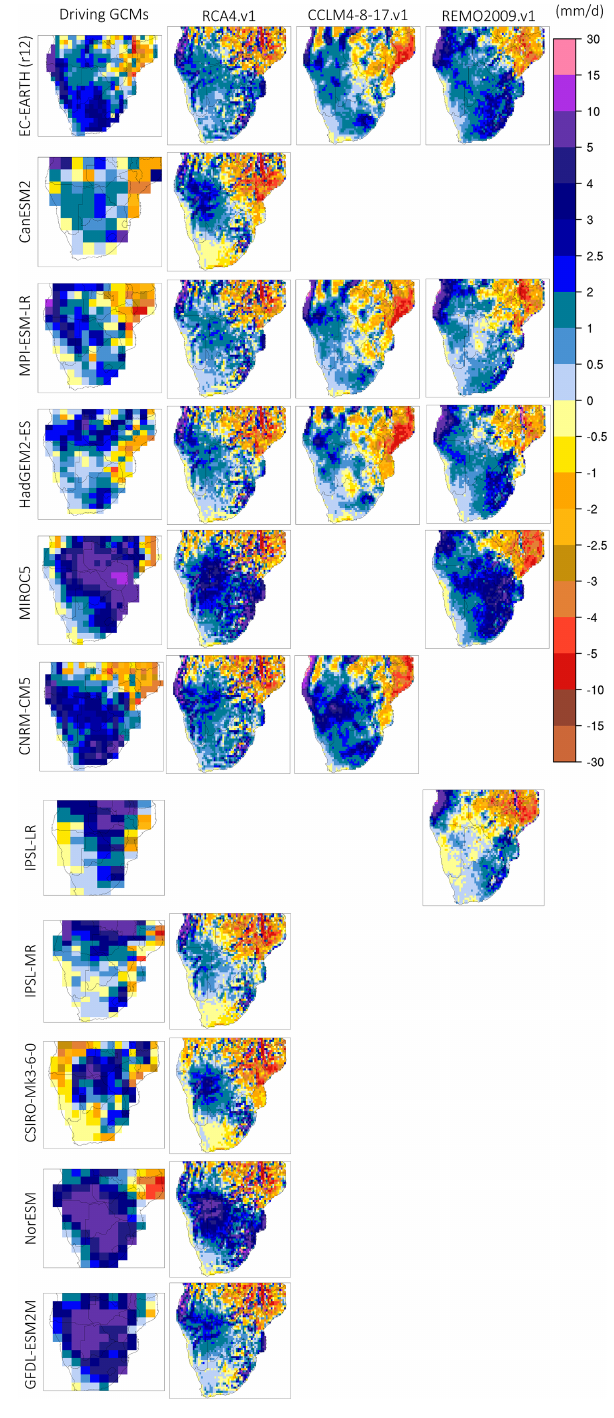
Figure 6. Monthly precipitation biases (model–CHIRPS, in mmd − 1 ) during January for the period 1985–2005. The first col- umn (from the left) displays precipitation biases from the driving GCMs used, and columns 2–4 display the biases in the downscaled precipitation output according to RCA4.v1, CCLM4-8-17.v1, and